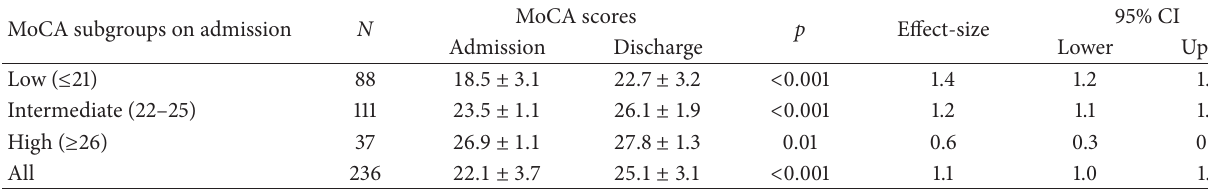
Table 3: MoCA scores on admission and at discharge and effect-size of the difference in the sample divided into three subgroups with increasing MoCA scores.